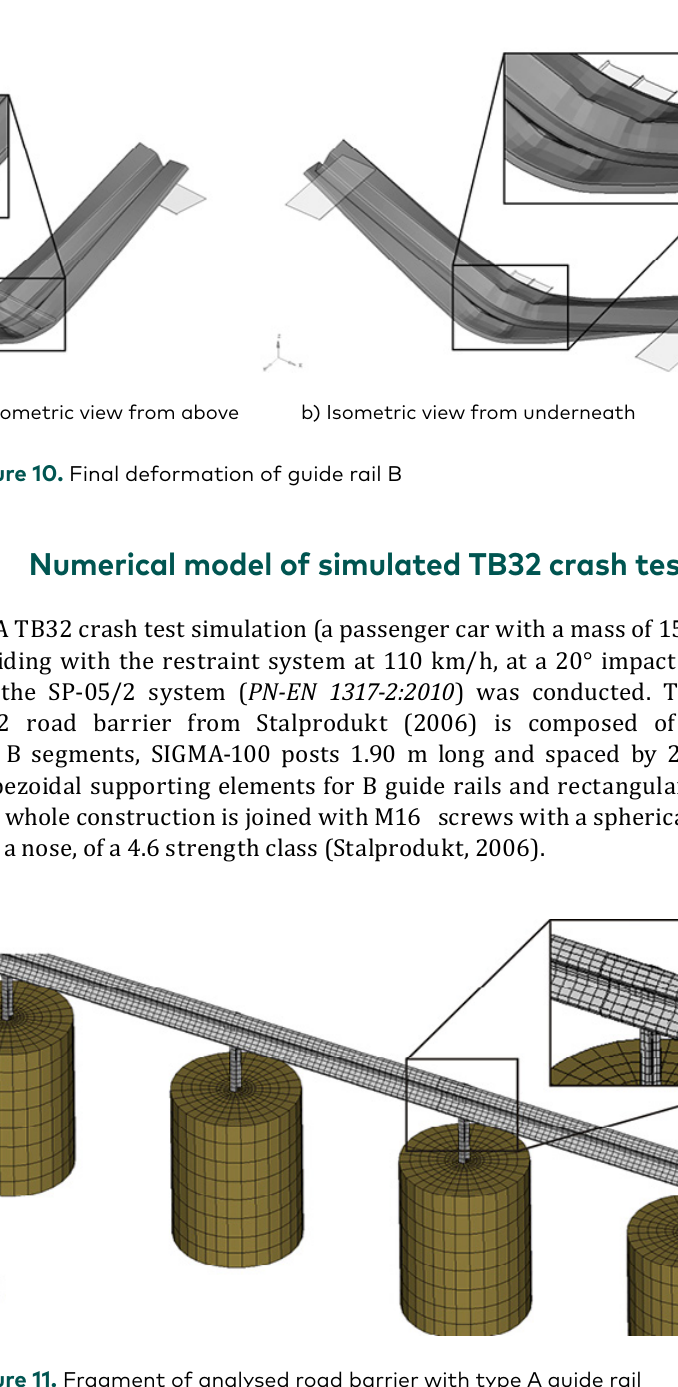
Figure 11. Fragment of analysed road barrier with type A guide